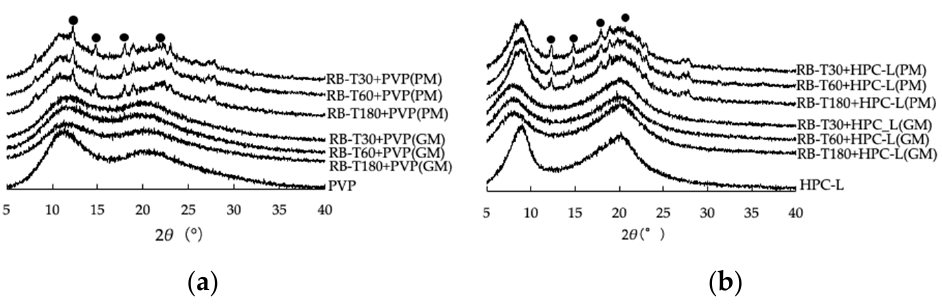
Figure 2. Powder X-ray diffraction patterns of various mixtures: ( a ) with PVPK-30 and ( b ) with HPC-L.